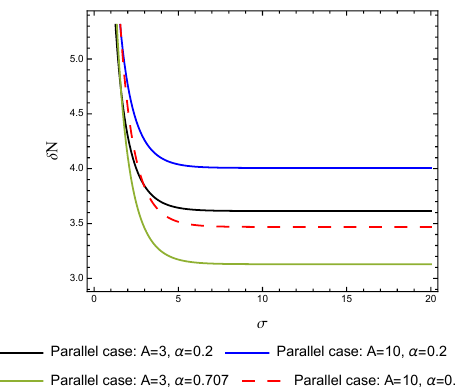
Figure 24 . Parallel motion in (1 + 3) -dimensions with thermal background: variation of δ N as a function of σ with fixed α and A , with the choice ∆ E